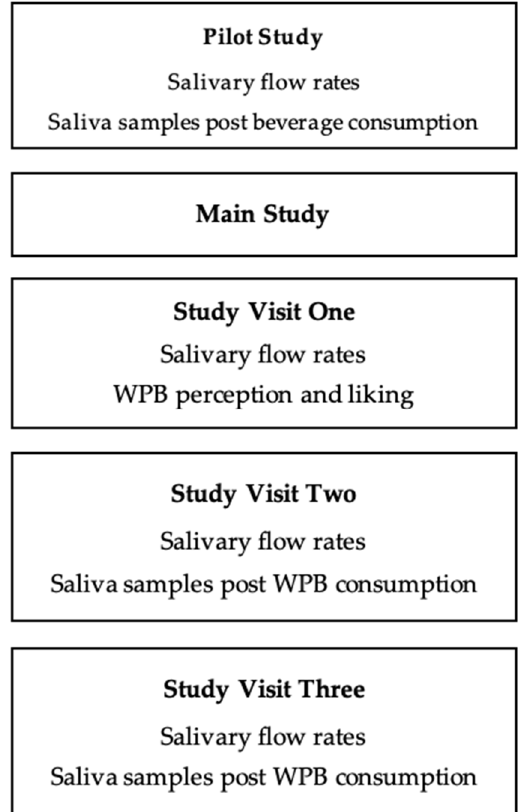
Figure 1. Overview of pilot and main studies (WPB: whey protein beverage).